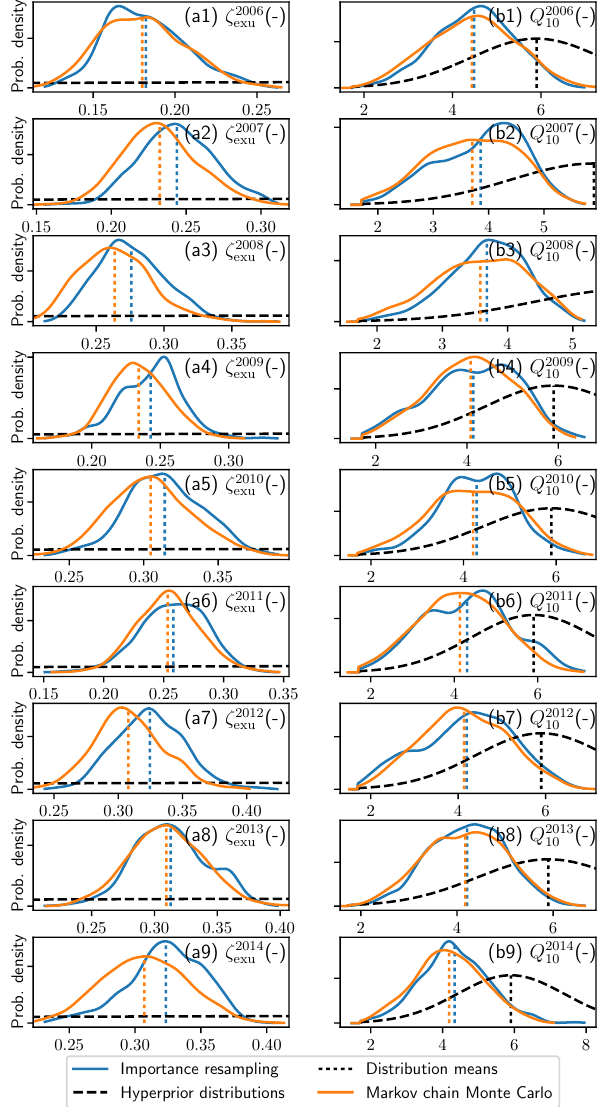
Figure 14. Posterior marginal distributions of the hierarchical pa- rameters from both MCMC and importance sampling, along with the hyperpriors. Panels (a1) – (a9) are for the parameters ζ , and (b1) – (b9) for Q 10 . The curves shown are smoothed slightly using Gaussian kernel estimates for readability. To make these figures, 70% from the start of the MCMC chain was discarded as a warm up. The dotted vertical lines show the default parameter values and the mean values of the posterior distributions. Importance resam- pling had the tendency of moving the posteriors of the ζ parameters slightly higher, despite the weaker prior used for that